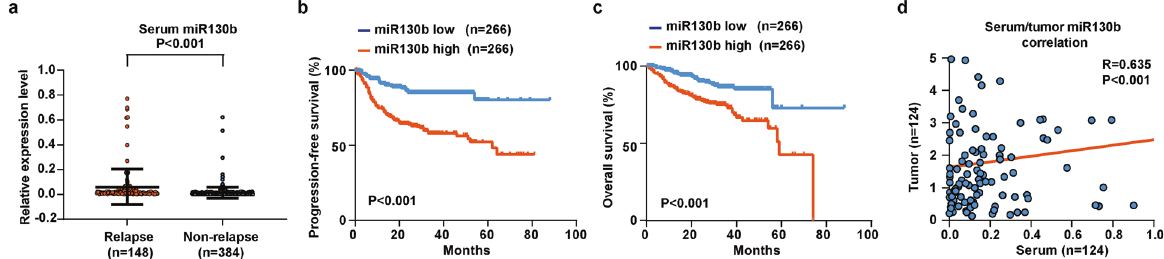
Fig. 1 Elevated serum miR130b was signi fi cantly associated with lymphoma progression in DLBCL. a Real-time PCR analysis of miR130b expression in relapse patients ( n = 148) and non-relapse patients (n = 384). b , c Progression-free survival (PFS) ( b ) and overall survival (OS) curves ( c ) in DLBCL patients according to miR130b expression. d Correlation between serum miR130b and tumor miR130b expression ( n = 124) calculated by Pearson correlation coef fi cient